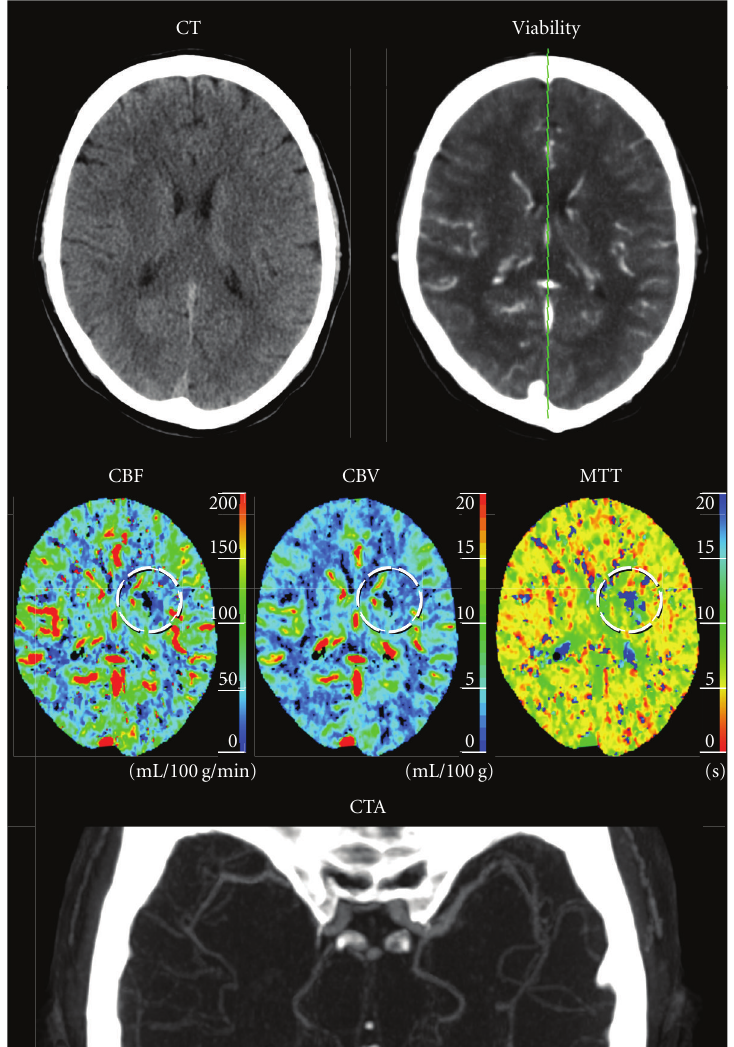
Figure 7: Case 3: 49-year-old male with right sided stroke symptoms and a normal NECT. The CTP source images show a small perfusion deficit in the left corona radiata with a marked decrease of both CBF and CBF (circle) that was initially missed by both the radiologist and the automated viability map software. CTA was normal.